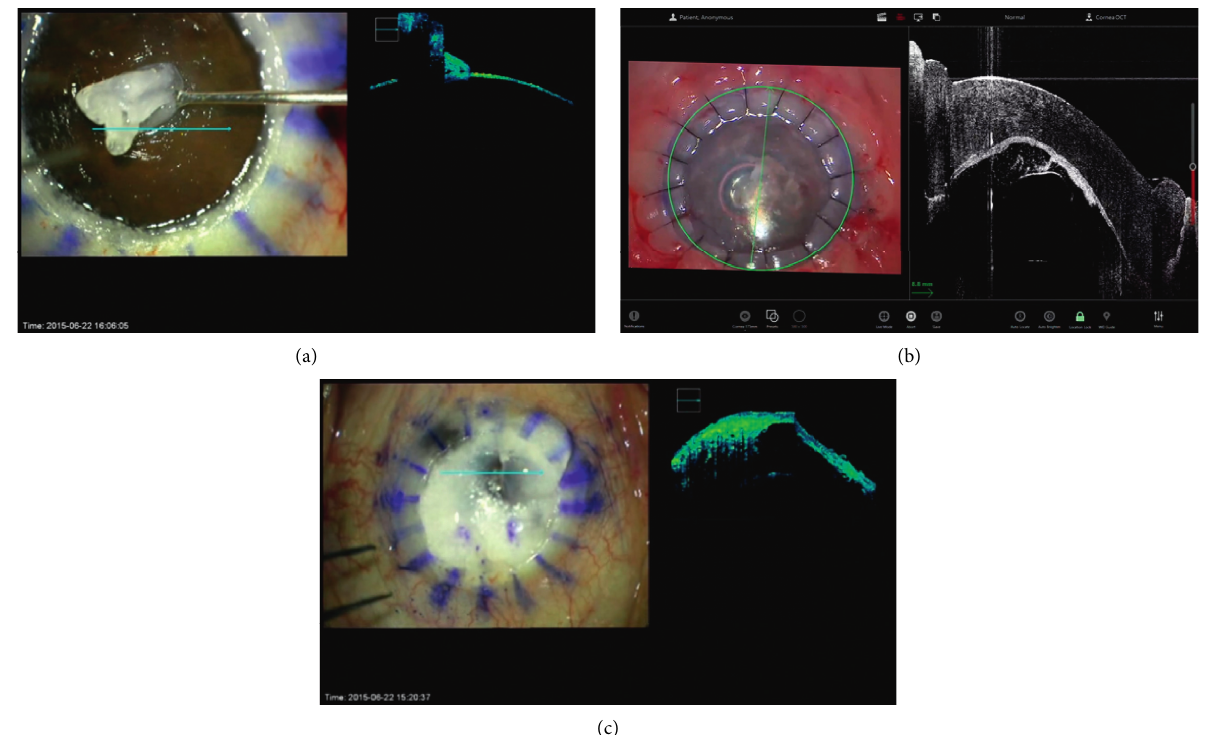
Figure 2: Application of the iOCT in DALK surgery. (a) Visualization of the residual stromal bed. (b) Confirmation of the attachment between the graft cornea and recipient bed (c) visualization of the tissue underneath the cloudy cornea using the iOCT during the